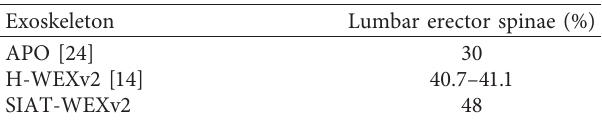
Figure 11: (a) iEMG of LES with loads from 0kg to 25kg; (b) efficiency with Table 2: Comparison of the reduction of the three kinds of exo- skeleton myoelectric activity.